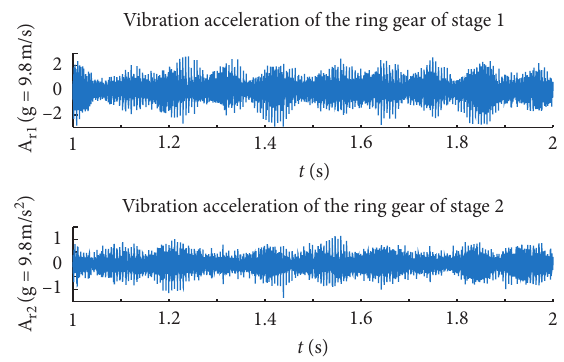
Figure 11: Vibration acceleration of ring gears.